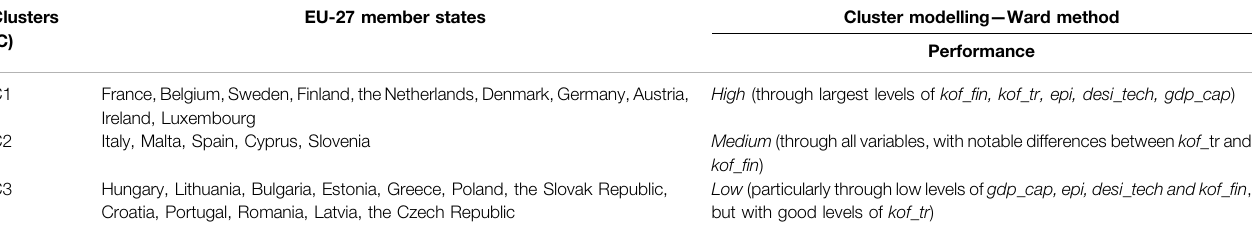
TABLE 5 | Clusters associated results with the interlinkages between trade and fi nancial globalization, environmental performance, digital transformation and sustainable economic development, EU-27, 2018. Clusters EU-27 member states Cluster modelling — Ward method (C)